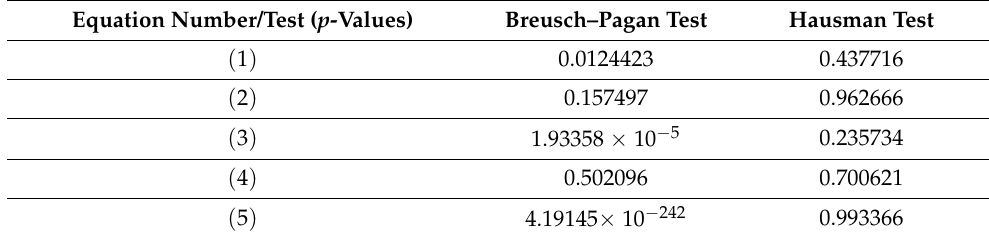
Table 2. Model specification